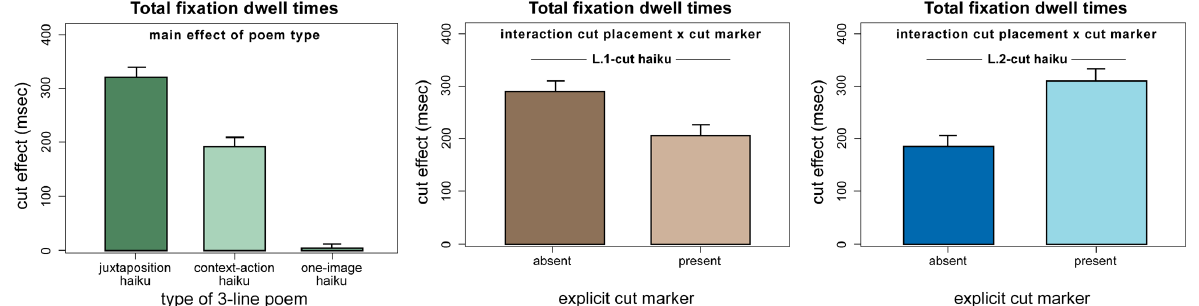
Figure 3 . Results from the analysis of overall dwell times. Cut effects (differences in scanning time between the fragment and the [remote] phrase line) scale with semantic-conceptual features of three-line poems (juxtaposition > context-action > one-image haiku; left panel) and with their formal-structural properties, such as the use of punctuation (middle and right panels). Punctuation may render the cut between the BG and FG image perceptually/cognitively more salient and thus, in L.1-cut haiku, focus information uptake on the post-cut lines. As a result, punctuation brings about a reduction of fragment line scanning times for haiku with a cut after line 1 (L.1-cut haiku), while at the same time increasing fragment line scanning times for haiku with a cut after line 2 (L.2-cut